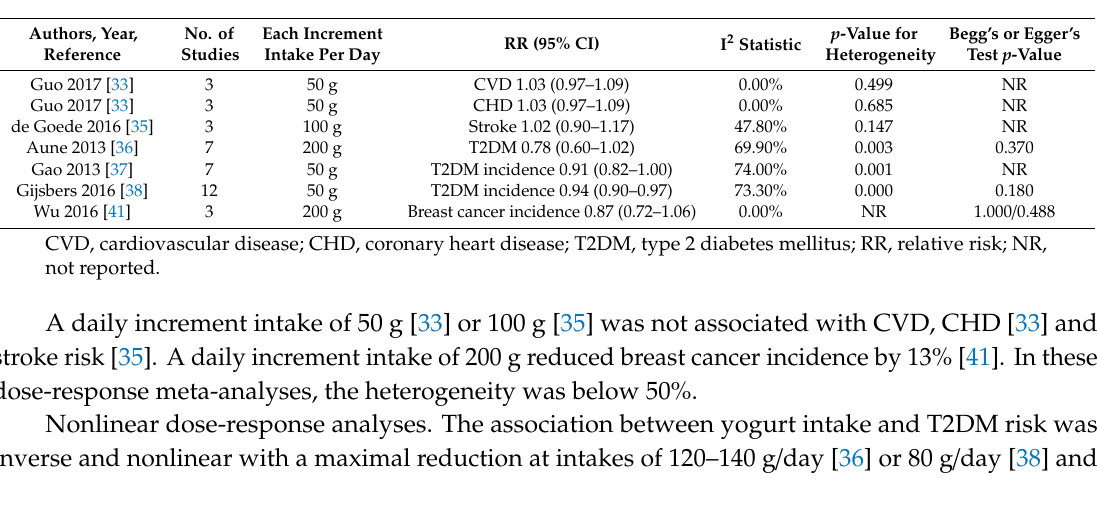
Table 6. Summary of linear dose-response meta-analyses of prospective studies on yogurt intake and CVD, CHD, stroke, T2DM, and breast